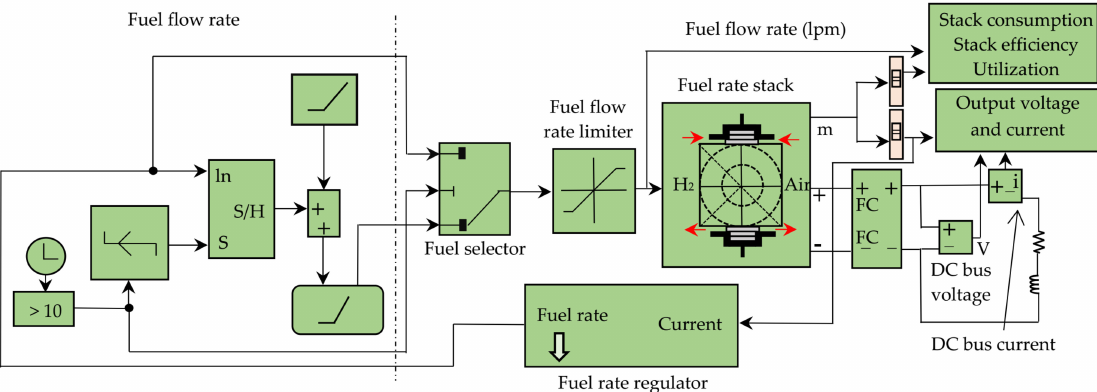
Figure 10. Complete simulation setup of the PEMFC model for characterisation.